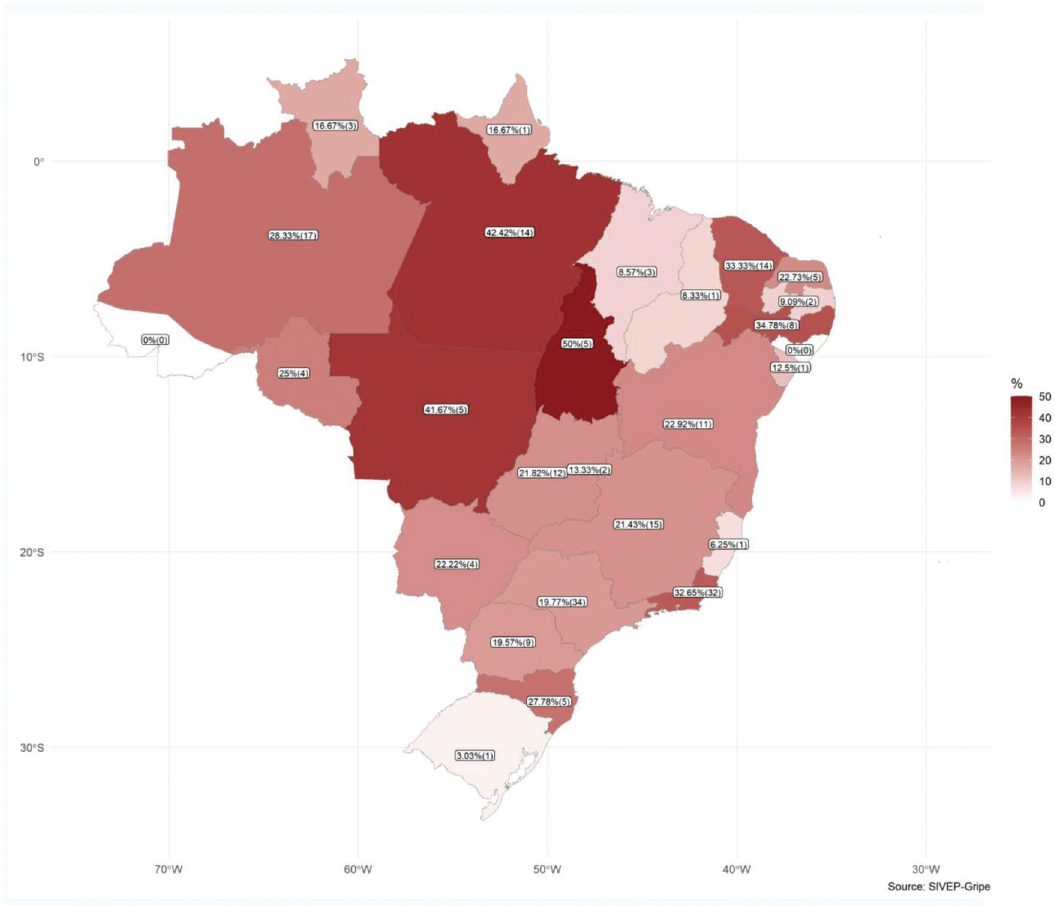
Figure 2 - Non-admission of pregnant and postpartum women with confirmed coronavirus disease (COVID-19) to intensive care units.